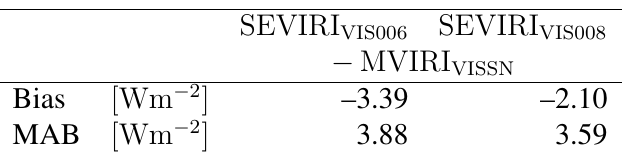
Table 2. Bias and MAB between Meteosat 7 and the different channels of Meteosat